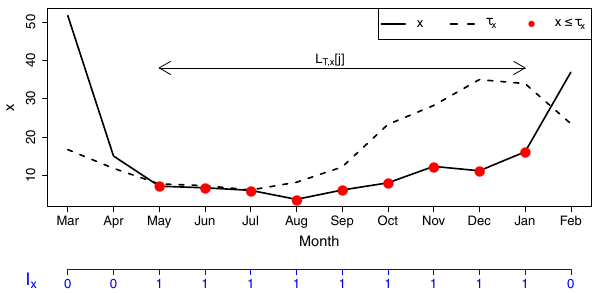
Figure 2. Schematic time series of variable x and correspond- ing drought threshold τ x with derived duration of drought event j ( L T,x [ j ] ) and binary index time series of monthly drought occur- rence ( I x ) .